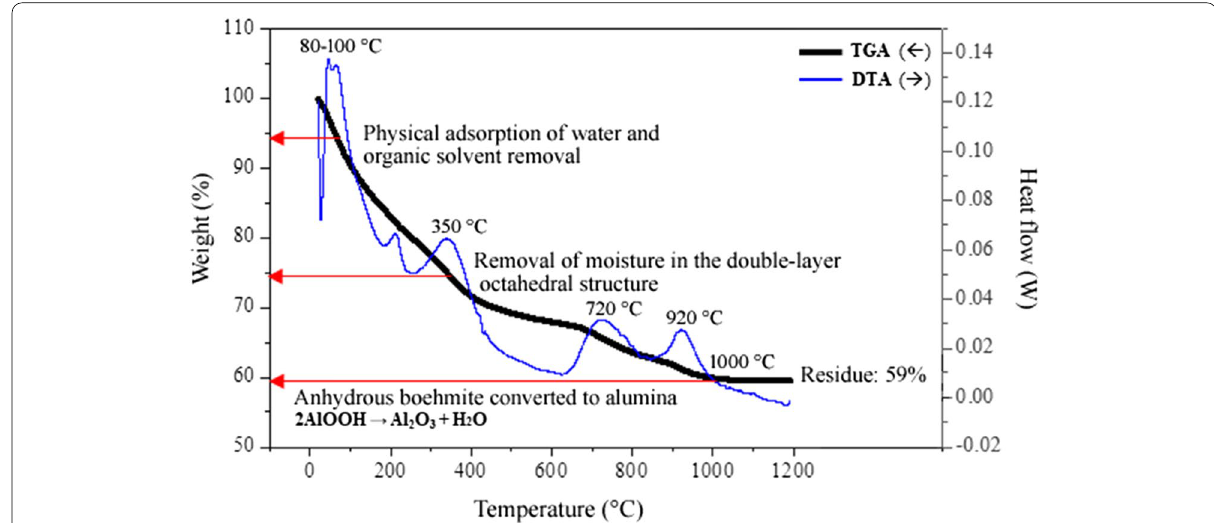
Fig. 10 TGA/Differential thermal analysis curve of aluminum